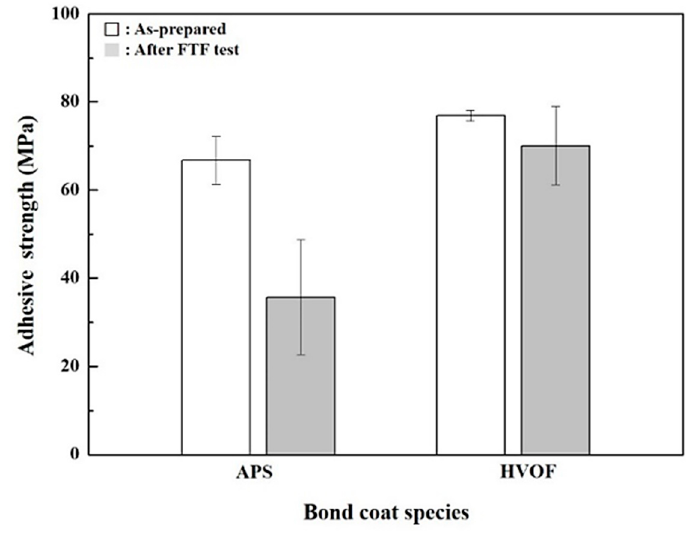
Figure 7. Adhesive strength values of TBCs before and after FTF tests.